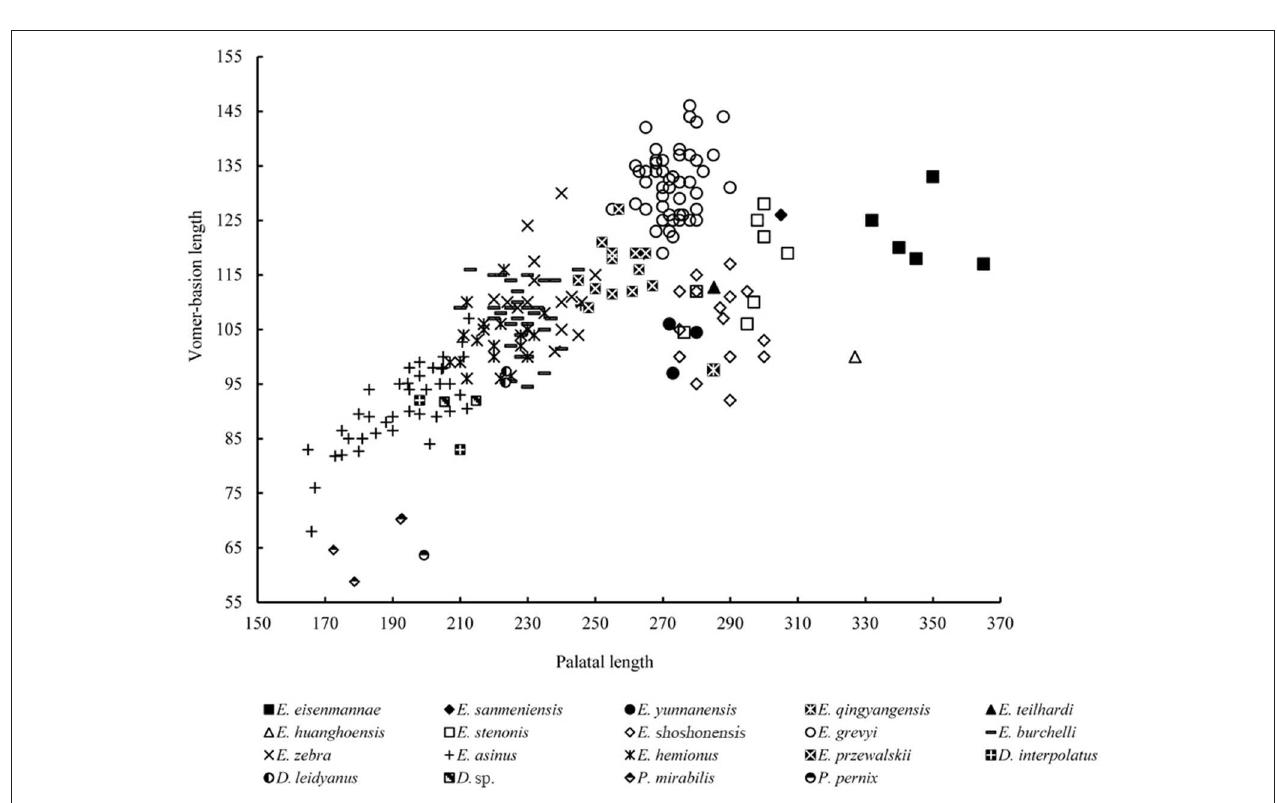
FIGURE 6 | Comparison of lengths of palatine and basicranial in several extinct and extant species of Equidae. Abbreviations of genera: E , Equus ; D , Dinohippus ; P , Pliohippus (same in below).